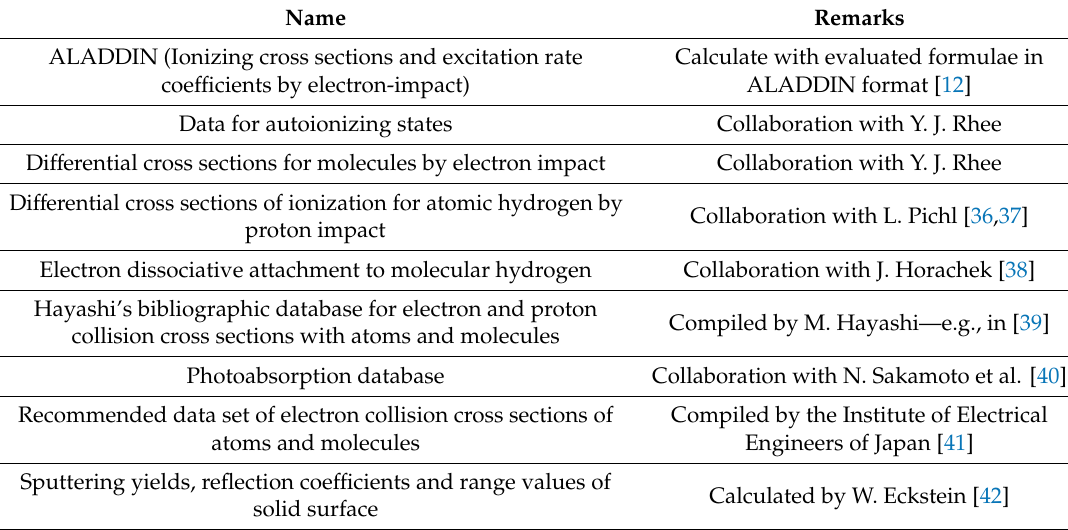
Table 3. List of satellite databases 1